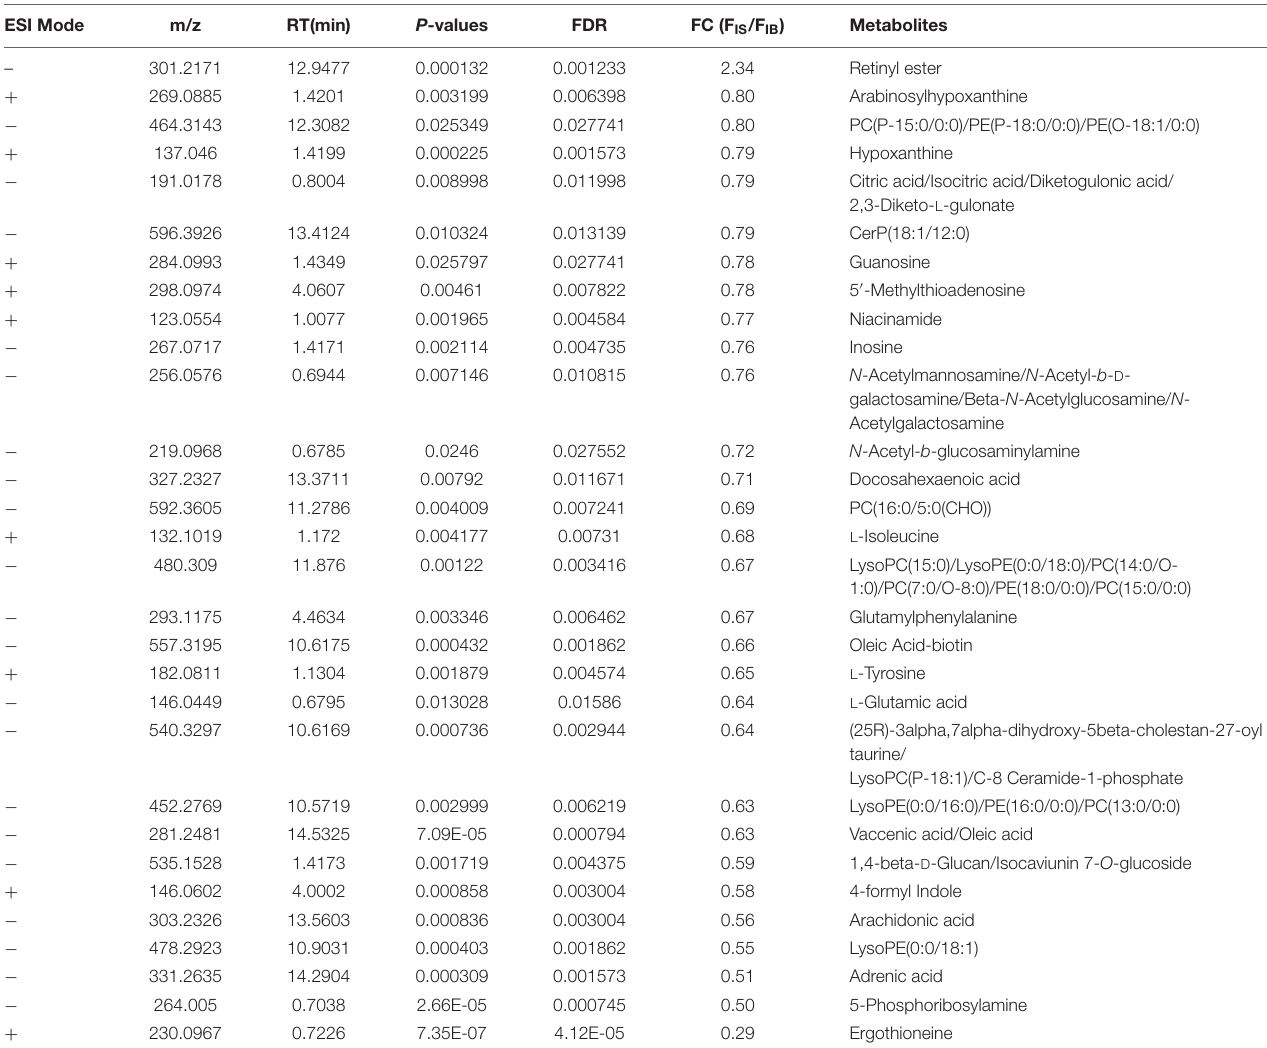
TABLE 3 | List of the female worm-specific differential metabolites between SCID mice and BALB/c mice. ESI Mode P -values FDR FC (F IS /F IB )